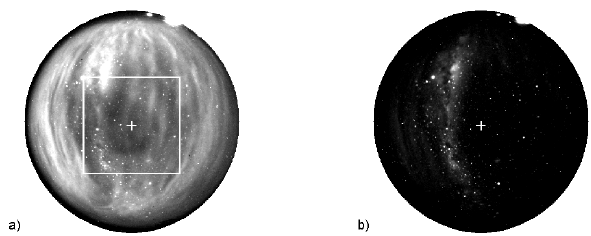
Fig. 1. An all-sky image in sodium emission (a) , and at a back- ground wavelength (b) , shown on the same gray-scale range. North is at the top and East to the right of the images, and the approx- imate 150km field-of- view analyzed is shown on the Na image. Gravity-wave structures aligned N–S, and moving towards the west, are apparent in the Na airglow image, whilst the stellar and galac- tic backgrounds that must be removed before processing are more obvious in the background image. Fig. 2. The annual sampling distribution of usable image observa-